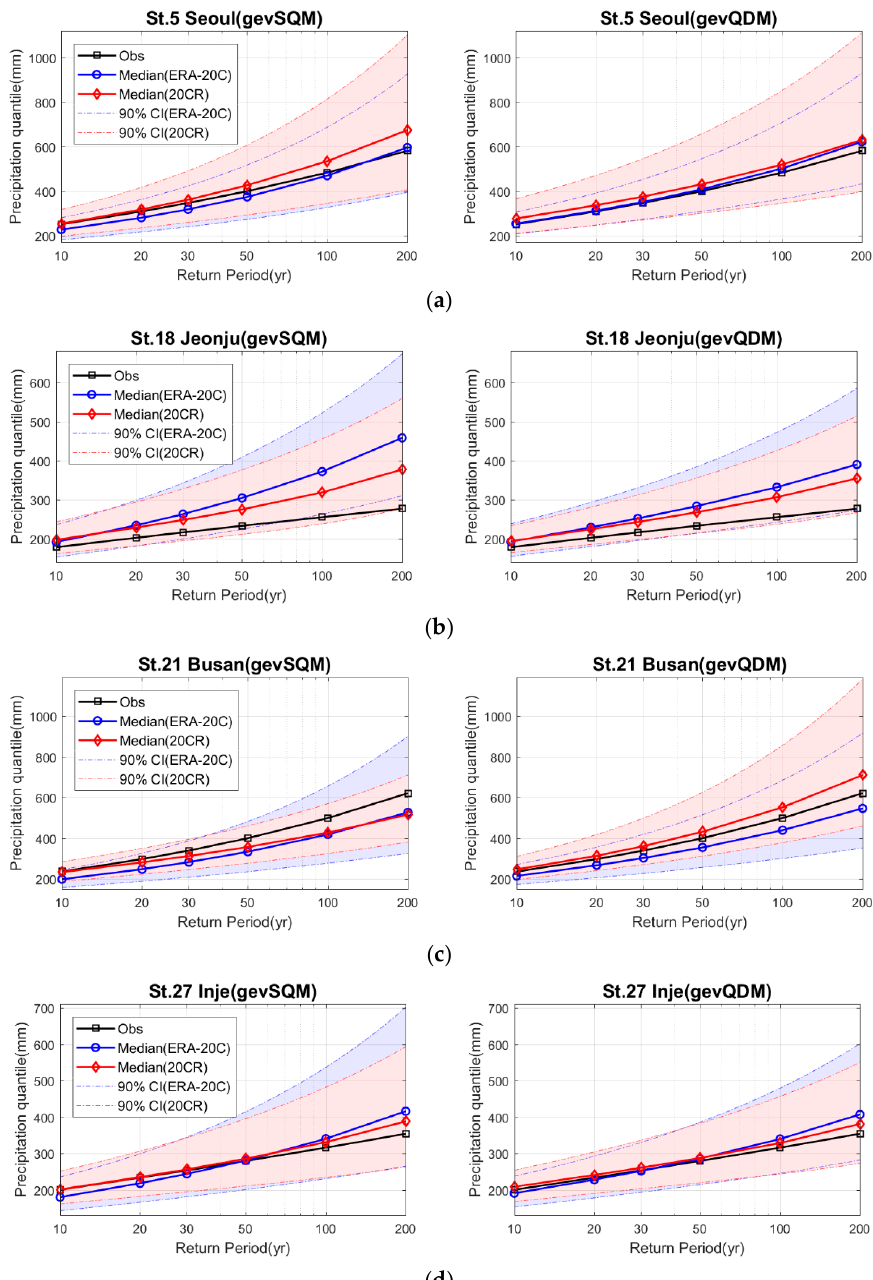
Figure 10. Precipitation quantiles by the conventional GEV model using the AMRs of observation (black line) for the reference period (1974–2010) and the nonstationary GEV models using the bias ‐ corrected ERA ‐ 20c and 20CR derived from gevSQM and gevQDM in 5 stations. ( a ) St.5 Seoul, ( b ) St.18 Jeonju, ( c ) St.21 Busan and ( d ) St.27 Inje. To find out the spatial influence of non ‐ stationarity in design rainfall, we estimated the relative change (%) of design rainfall with 100 ‐ year return period based on the median values of the generated parameter chains in 48 stations. The relative change in 48 stations varied from − 38.1% to 58.4% for gevSQM, and from − 30.8% to 42.8% for gevQDM, respectively, but the spatial comparisons in Figure 11 illustrated the increase of the relative change (%) in many regions over South Korea.